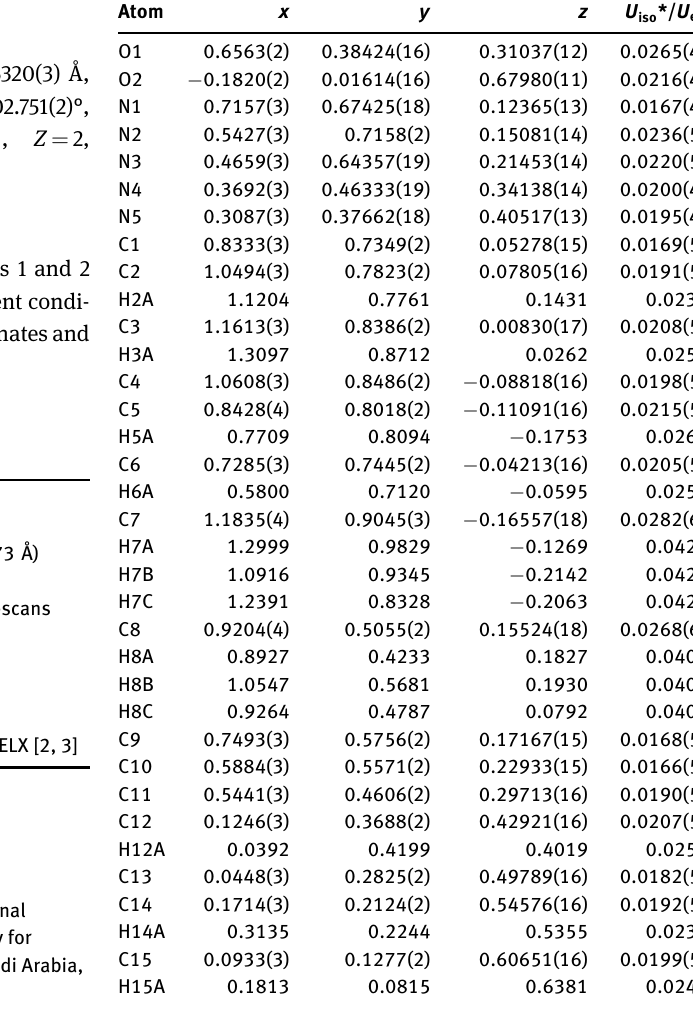
Table 2: Fractional atomic coordinates and isotropic or equivalent isotropic displacement parameters (Å 2